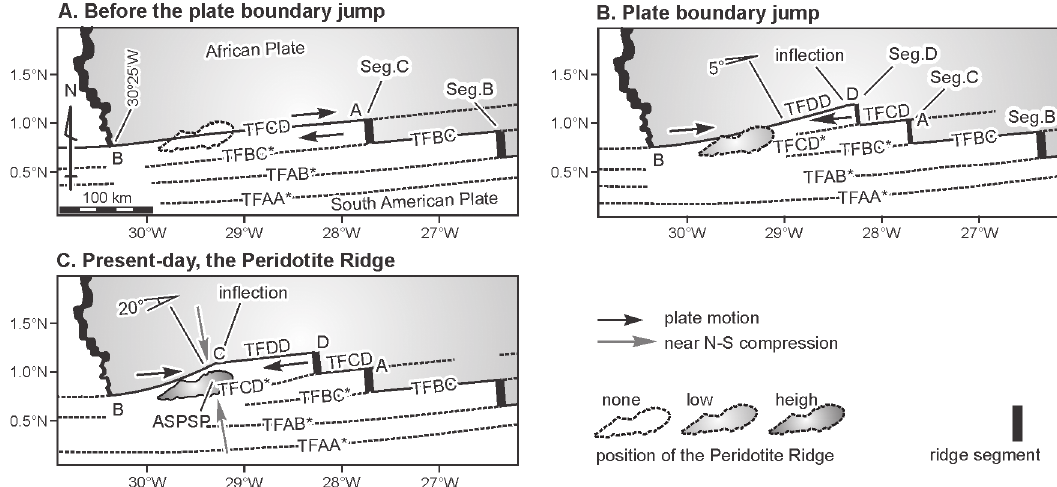
Figure 15 - Schematic illustrations for the active uplift of Saint Peter and Saint Paul peridotite ridge, Equatorial Atlantic Ocean, modified from Sichel et al. (2011): A) Before the plate boundary jump at 8 Ma, with 3 ridge segments in the conventional layout; B) Emergence of Segment D at 8 Ma and plate boundary jump from TFCD* to TFDD; C) Present-day state, with increasing near north-south compression and the consequent accelerating uplift of the Peridotite